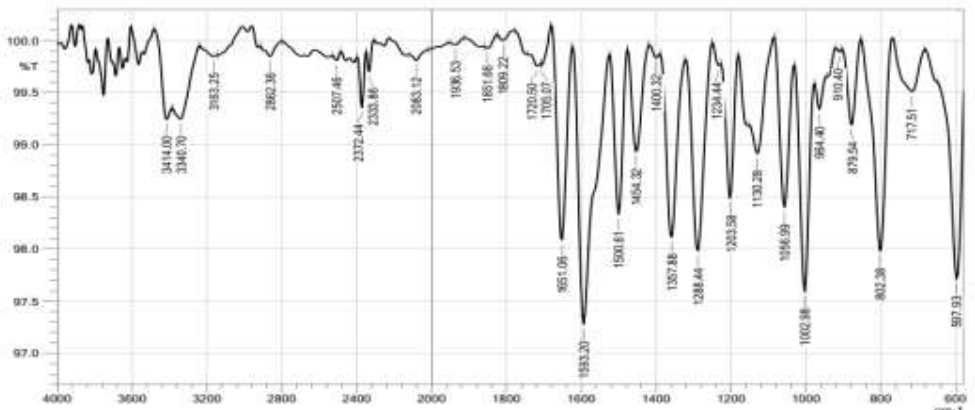
Figure 7. FTIR spectra of the isolated